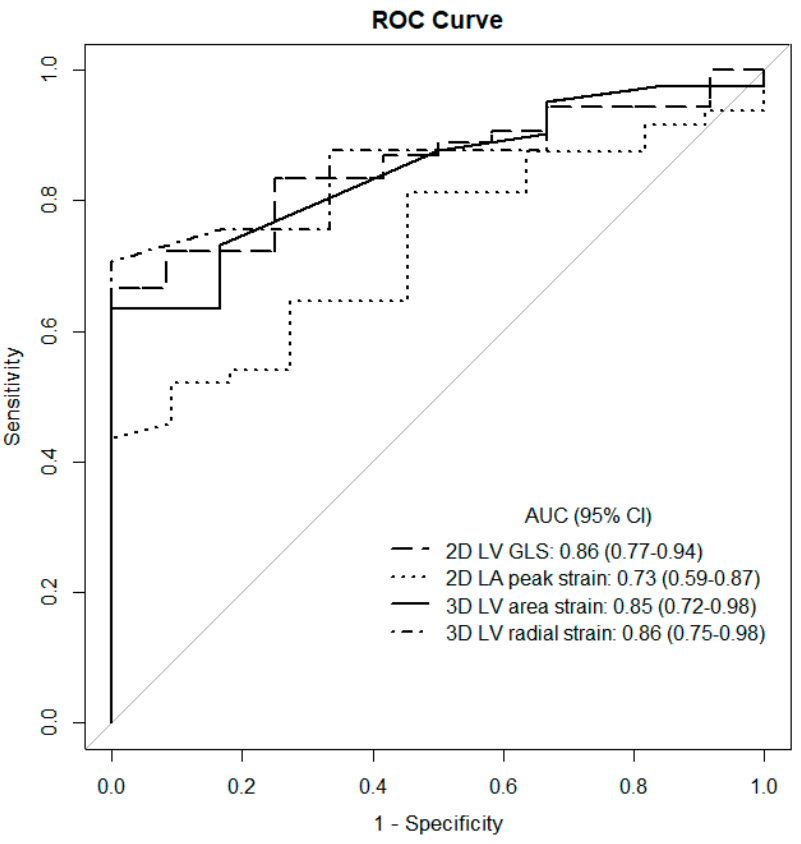
Figure 6. ROC curves of 2D and 3D STE parameters. LAVi, LA peak strain, LV strains, and LVEF with prespecified cut-off values calculated from the ROC curves were significant predictors of AF in the univariate logistic regression analysis that was not confirmed for LADs (Table 4). Table 4. Univariate logistic regression analysis as a predictor of the composite endpoint.